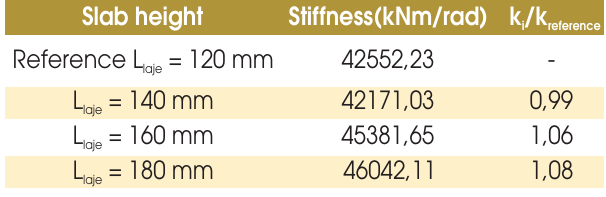
Figure 20 – Comparison of bending moment versus rotation curves and envelope curves used for parametric analysis of the bolts diameter